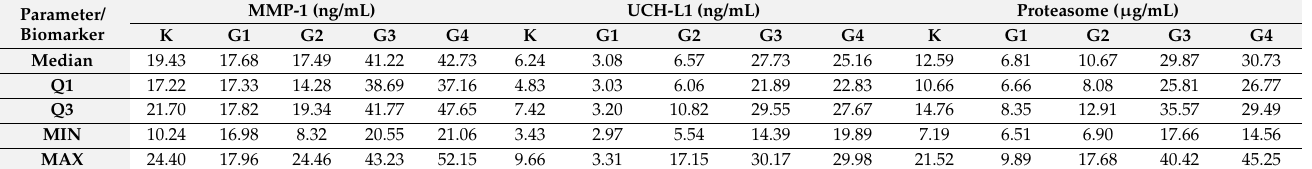
Figure A1. Scheme of analytical procedure for quantification of MMP-1, UCH-L1, and 20S proteasome in blood plasma. Table A2. Detailed data for Figure 4.